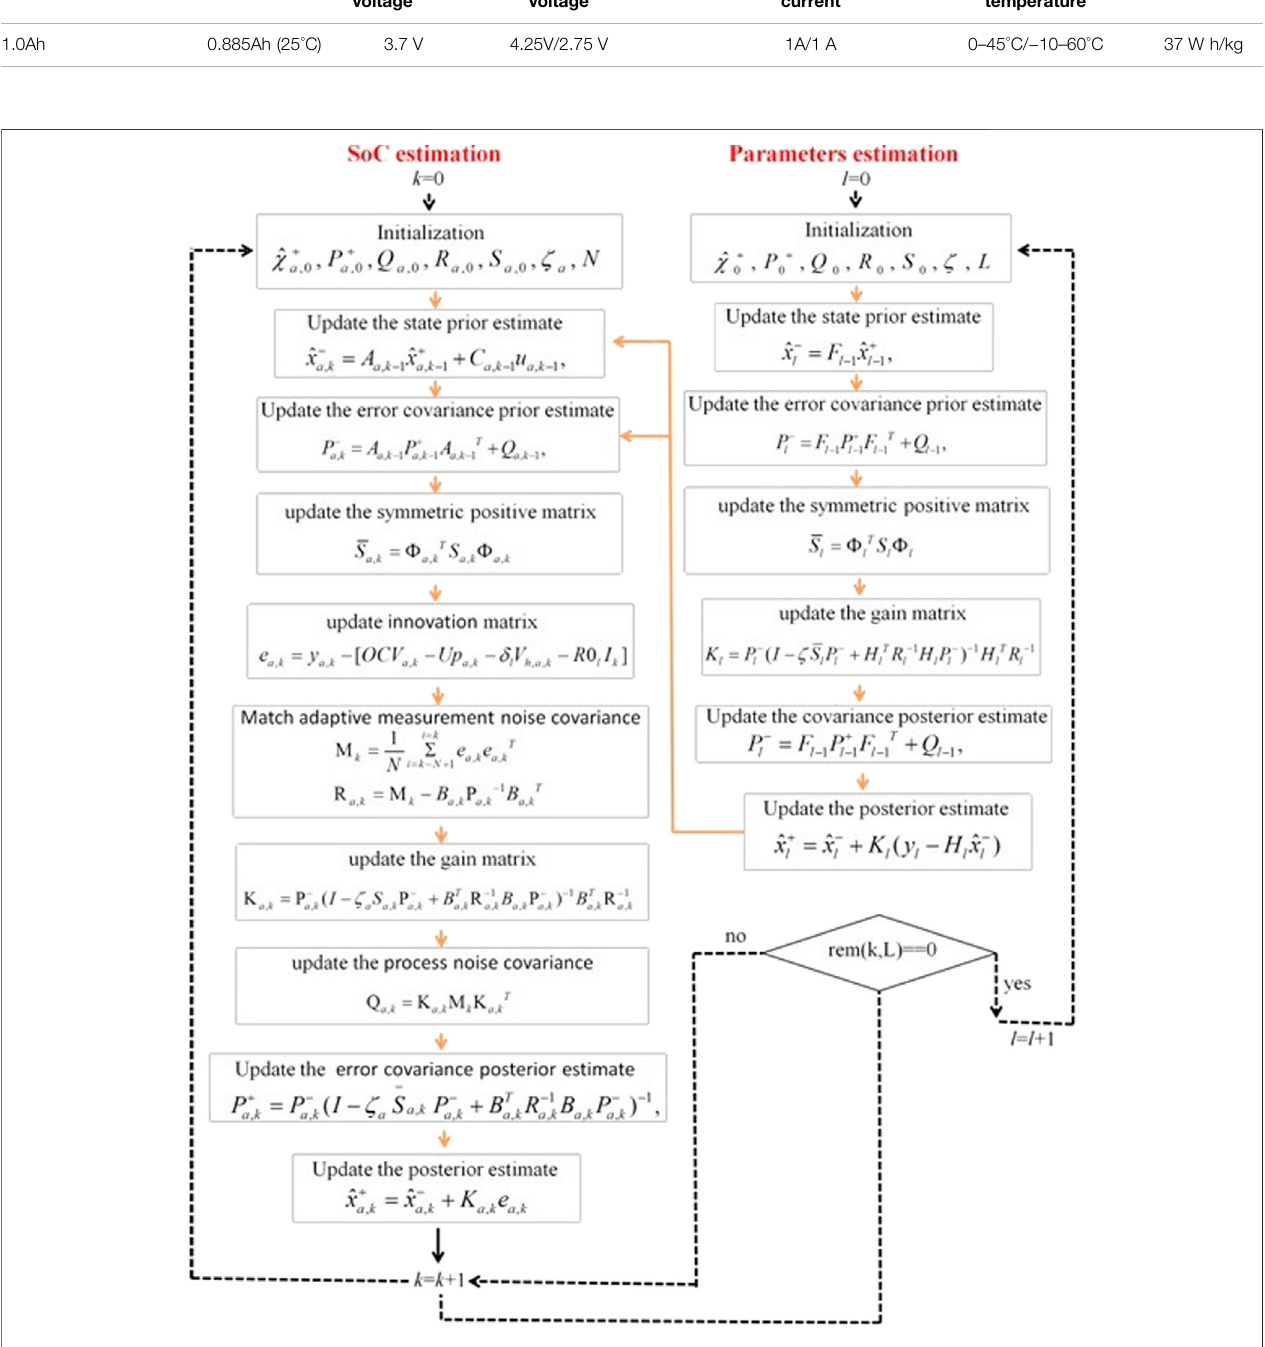
FIGURE 1 | The dynamic pulse current pro fi